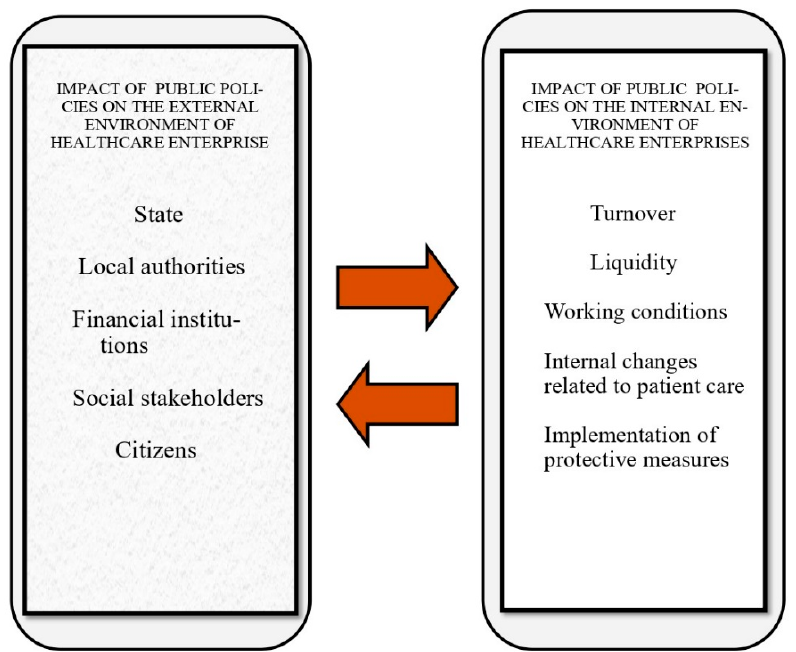
Figure 1. Impacts on the internal and external environment of health businesses by COVID-19 public restraint policies.